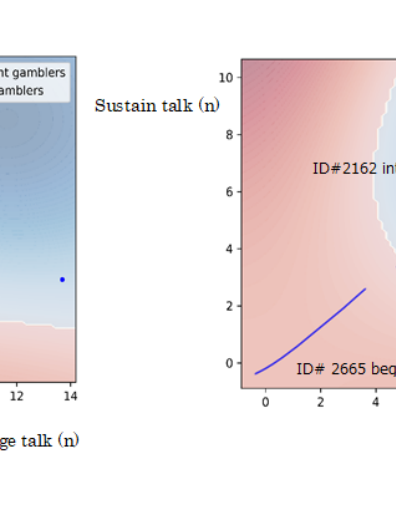
Figure 1. Change talk model for abstinence colored by evaluation values. Red areas indicate low abstinence likelihood areas (negative evaluation values), whereas blue areas indicate high abstinence likelihood areas (positive evaluation values). Horizontal and vertical lines represent standardized number of change and sustain talks, respectively. A: Scatter map of gamblers with and without current abstinent periods of at least three years. Blue circles and red Xs indicate abstinent and nonabstinent gamblers, respectively. B: Optimal recovery routes for 3 gamblers. Blue lines indicate 3 gamblers’ continuous optimal ways to increase their likelihood of gambling abstinence responding to their minute status differences. To clarify the meanings of the number of change and sustain talks, the numbers were unstandardized in the following cases. The beginner gambler (ID# 2665) started at 1 change talk and 1 sustain talk with evaluation value –1.000 and finished at 1657.16 change talks and 351.31 sustain talks with evaluation value –0.588 after 500 trials. The evaluation value at the end remained negative, thereby indicating low likelihood of gambling abstinence. The best portion of change talks (number of change talks/number of change and sustain talks) for the beginner (ID# 2665) during web-based anonymous gambler chat meetings was regarded as 0.8254. The intermediate gambler (ID# 1008) started at 3396 change talks and 259 sustain talks with evaluation value –0.063 and finished at 4290.42 change talks and 787.67 sustain talks with evaluation value +2.815 after 500 trials. The evaluation value at the end turned positive, thereby indicating high likelihood of abstinence. The best portion of change talks for the intermediate gambler (ID# 1008) during web-based anonymous gambler chat meetings was regarded as